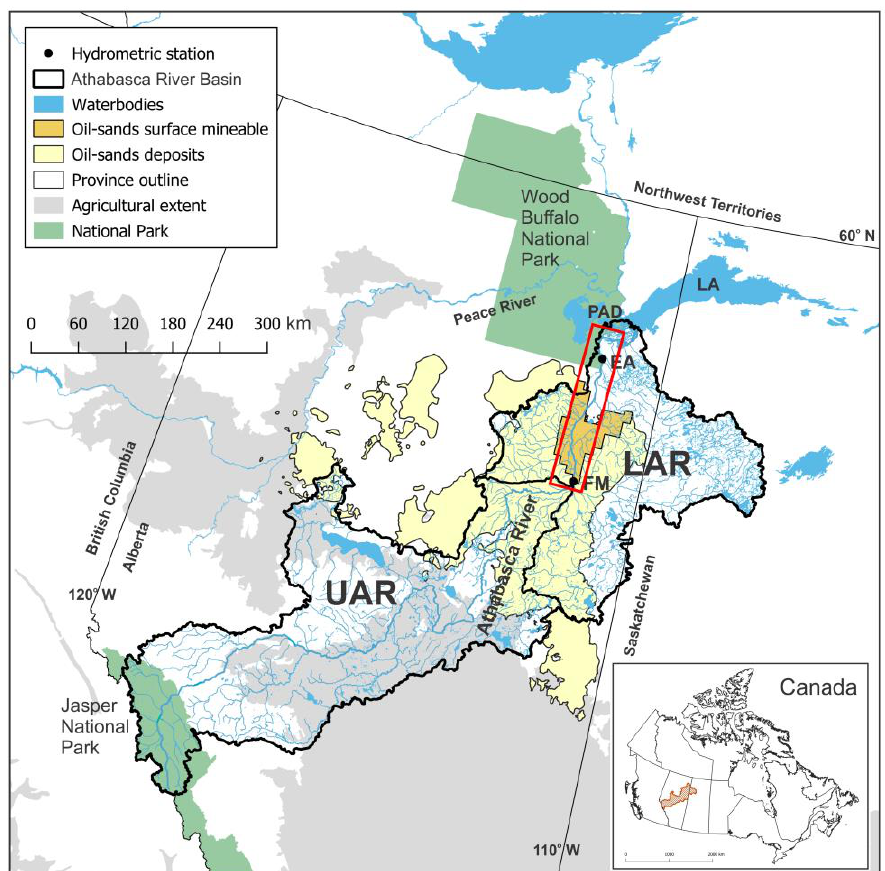
Figure 1. Athabasca River Basin in western Canada (modified from [21]). UAR and LAR are the upper and lower Athabasca River drainage areas, respectively. The study reach of interest is outlined in a red polygon with hydrometric gauges on the Athabasca River mainstem just below city of Fort McMurray (FM) and at Embarras Airport (EA). The Peace–Athabasca Delta (PAD) and Lake Athabasca (LA) are also shown. Inset map shows location of study basin within western Canada. The Athabasca River Basin drains eight physiological sub-regions of Alberta